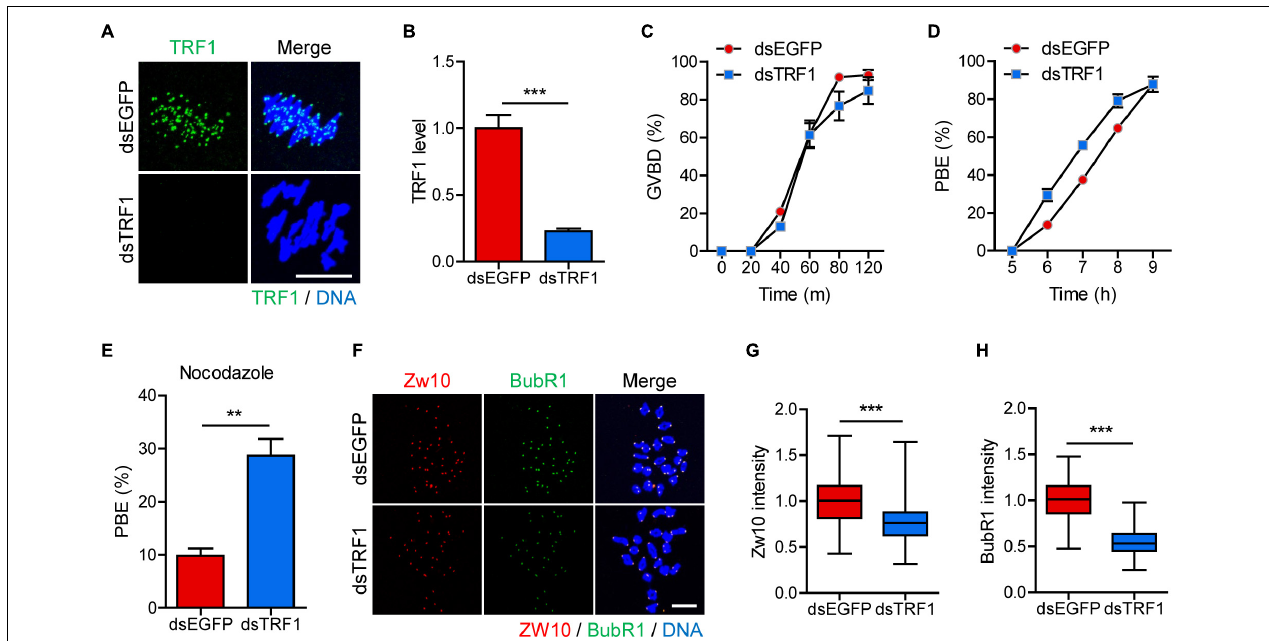
FIGURE 1 | TRF1 depletion accelerates polar body extrusion by abrogating the SAC. After microinjection of TRF1 dsRNA (dsTRF1) or control EGFP dsRNA (dsEGFP), the oocytes were cultured in M2 medium containing IBMX for 24 h and then transferred to IBMX-free M2 medium for up to 16 h. (A,B) Oocytes at MI stage (8 h after IBMX release) were fixed and stained with anti-TRF1 antibody. DNA was counterstained with DAPI (scale bar, 10 µ m). TRF1 intensity was quantified and shown as mean ± SEM from at least four independent experiments with representative images. (C,D) Rates of GVBD and polar body extrusion (PBE) were scored. (E) Oocytes at the MI stage (8 h after IBMX release) were cultured in medium containing 20 µ g/ml nocodazole and were scored 6 h later for PBE. (F–H) Chromosome spreads were prepared from oocytes at the MI stage and were stained with anti-Zw10 and anti-BubR1 antibodies. DNA was counterstained with DAPI (scale bar, 20 µ m). The intensity of Zw10 and BubR1 was quantified from three independent experiments and shown with representative images. ** p < 0.01, *** p <